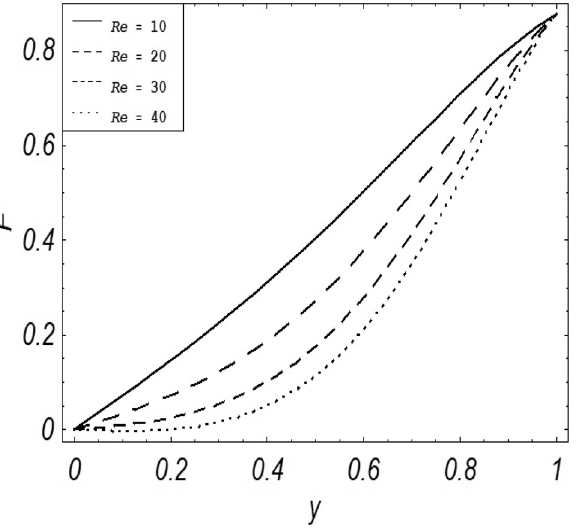
Figure 8. Evolution of F with various values of Re if t = 1 ; Gr = 2.5 ; N = 0.7 ; η = 2 ; Gr =